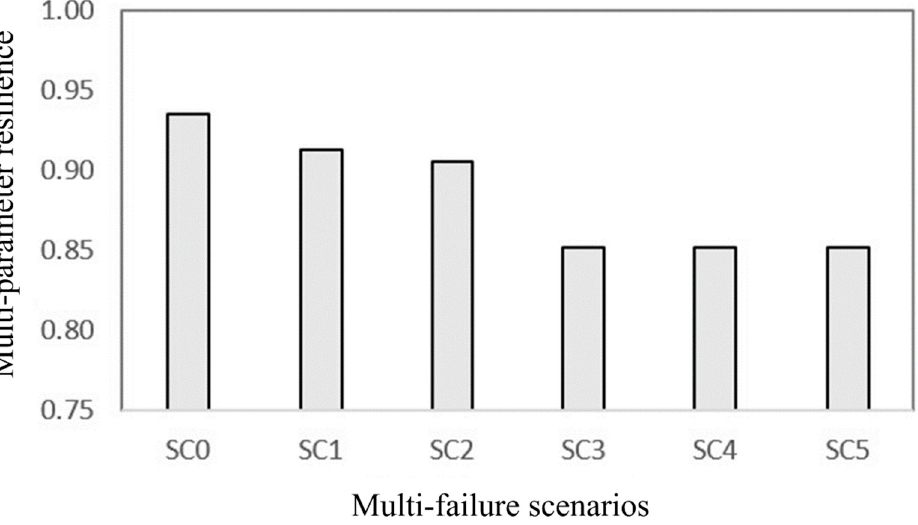
Figure 8. Multi-parameter dynamic resilience within the multi-failure scenarios.